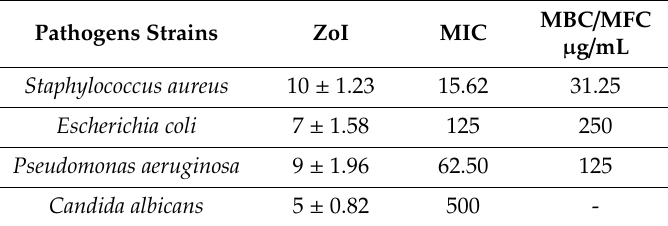
Table 4. Antimicrobial activity of Nannochloropsis oculata